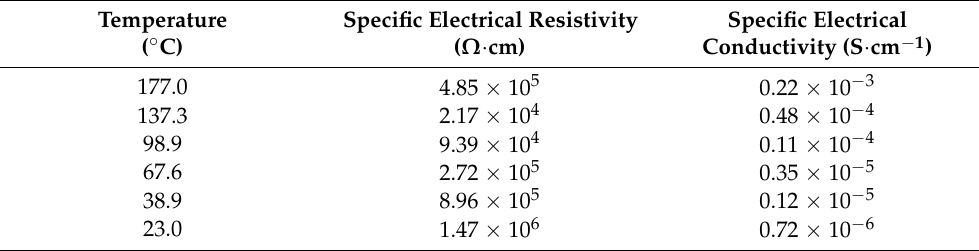
Table 4. Change in the value of specific electrical resistance and specific electrical conductivity with temperature change for